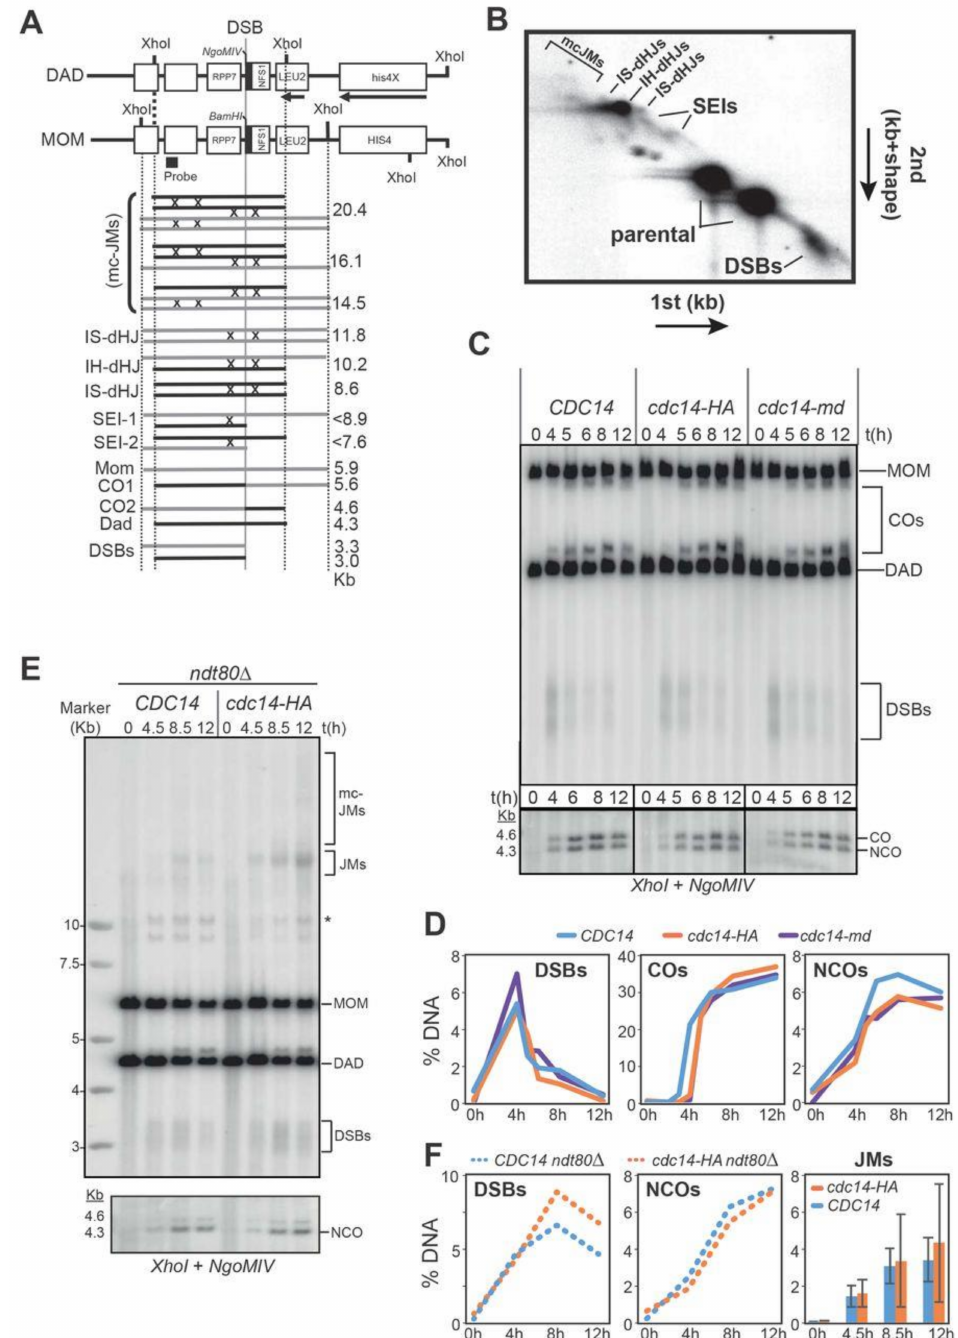
Figure 4. Analysis of meiotic recombination in meiotic-deficient cdc14 mutants. ( A ) Schematic illustration of recombination analysis and intermediates at the HIS4LEU2 hotspot (see Results for more details). ( B ) Schematic representation of DNA species commonly observed after analyzing the HIS4LEU2 hotspot by 2D-gel electrophoresis. (( C ); top ) Representative 1D-gel Southern blot for analysis of DSBs and COs at the HIS4LEU2 hotspot using XhoI as the restriction site. Wild-type strain (JCY2232), cdc14-HA (JCY2231), and cdc14-md (JCY2389). (( C ); bottom ) Analysis of COs and NCOs at the HIS4LEU2 hotspot using XhoI and NgoMVI in the same strains as in ( C ). ( D ) Quantification of DSBs, COs and NCOs from the Southern blots shown in ( C ). ( E ) Representative 1D-gel Southern blot image for analysis of DSBs, COs (top) and NCOs (bottom) at the HIS4LEU2 hotspot in CDC14 ndt80 ∆ strain (JCY2390) and cdc14-HA ndt80 ∆ (JCY2385) strains. Asterisk indicates meiosis-specific non-characterized recombination products. ( F ) Quantification of DSBs, NCOs and JMs from the Southern blots shown in ( E ). Error bars represent SEM over the calculated mean